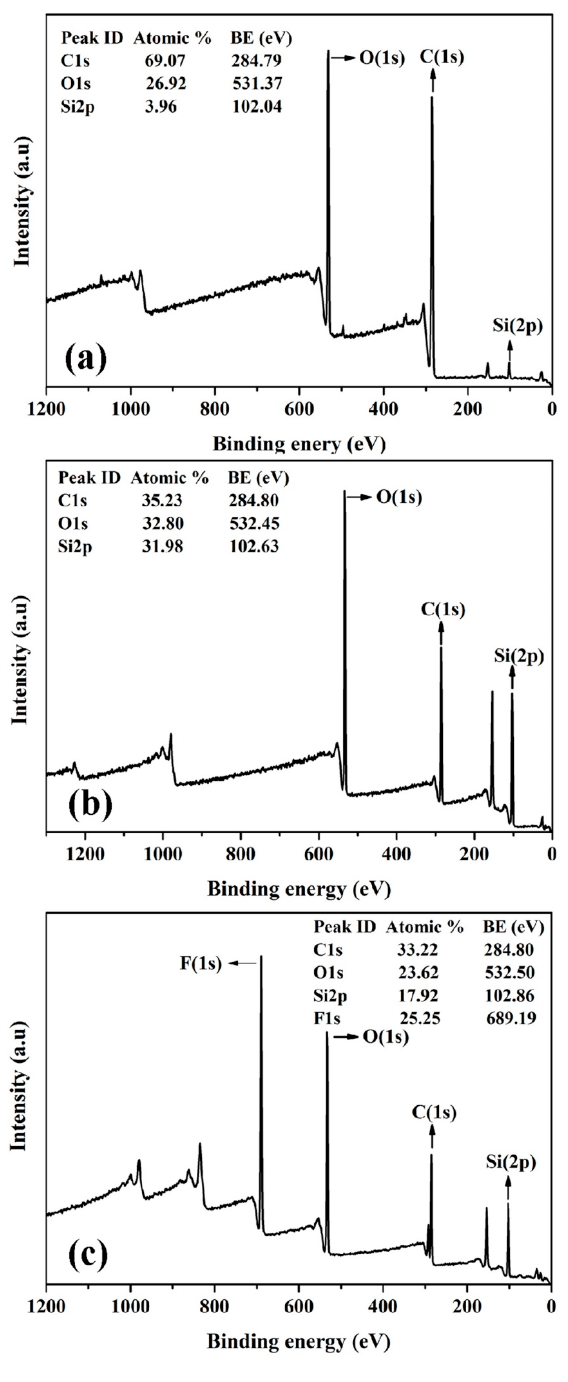
Figure 2. XPS survey spectra of pristine cotton fabric ( a ), PMHS-modified cotton fabric ( b ), and fluorinated olefin-modified cotton fabrics ( c ).